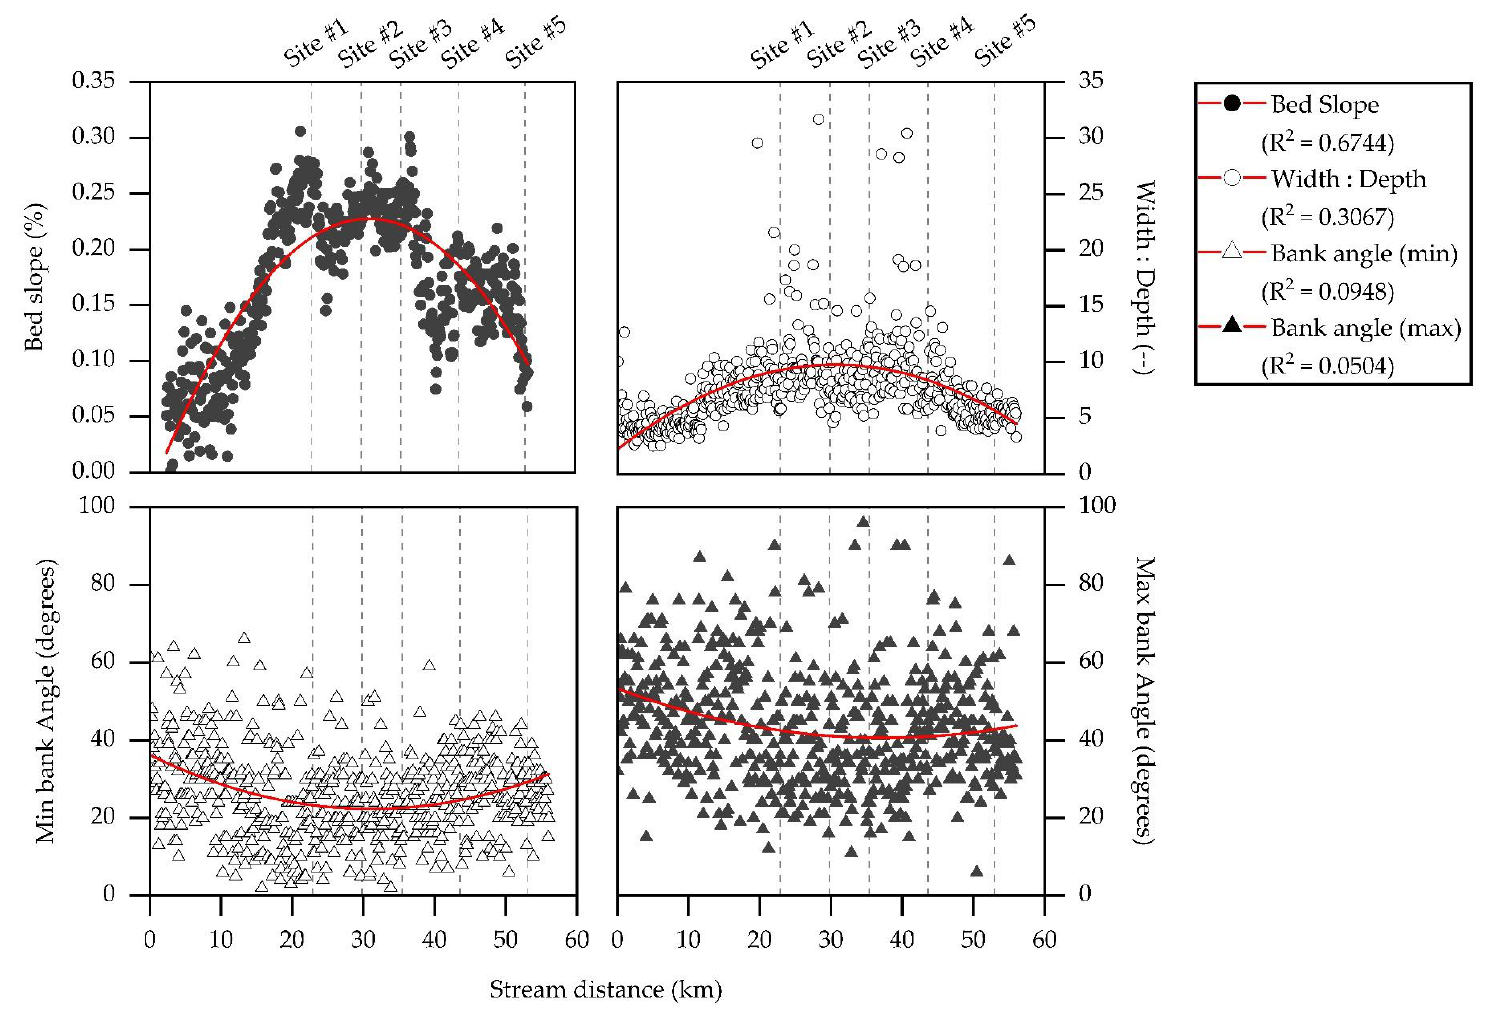
Figure 4. Trend lines associated with channel morphology variables with downstream distance (km) in Hinkson Creek Watershed, Missouri, USA. Vertical lines show location of five nested gauging sites.